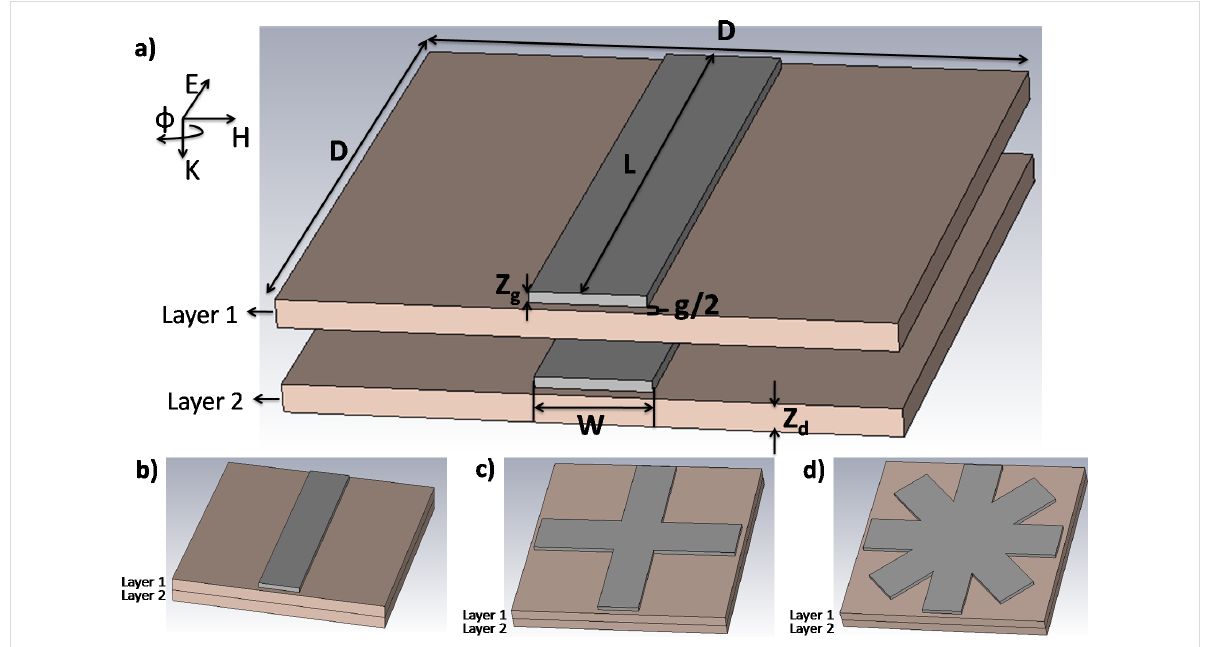
Figure 1: a) Illustration of cut-wire sandwich structure. W , L , g , Z d and Z g are width of cut wire (20 µm), length of cut wire (100 µm), the gap size of cut wire with its neighbor (5 µm), polyimide substrate thickness (5 µm), and tge cut-wire structure thickness (100 nm), respectively. D is the lattice con- stant ( D = L + g ). b) Sample 1: cut-wire sandwich structure, c) Sample 2: cross-shaped sandwich structure, d) Sample 3: star-shaped sandwich struc-